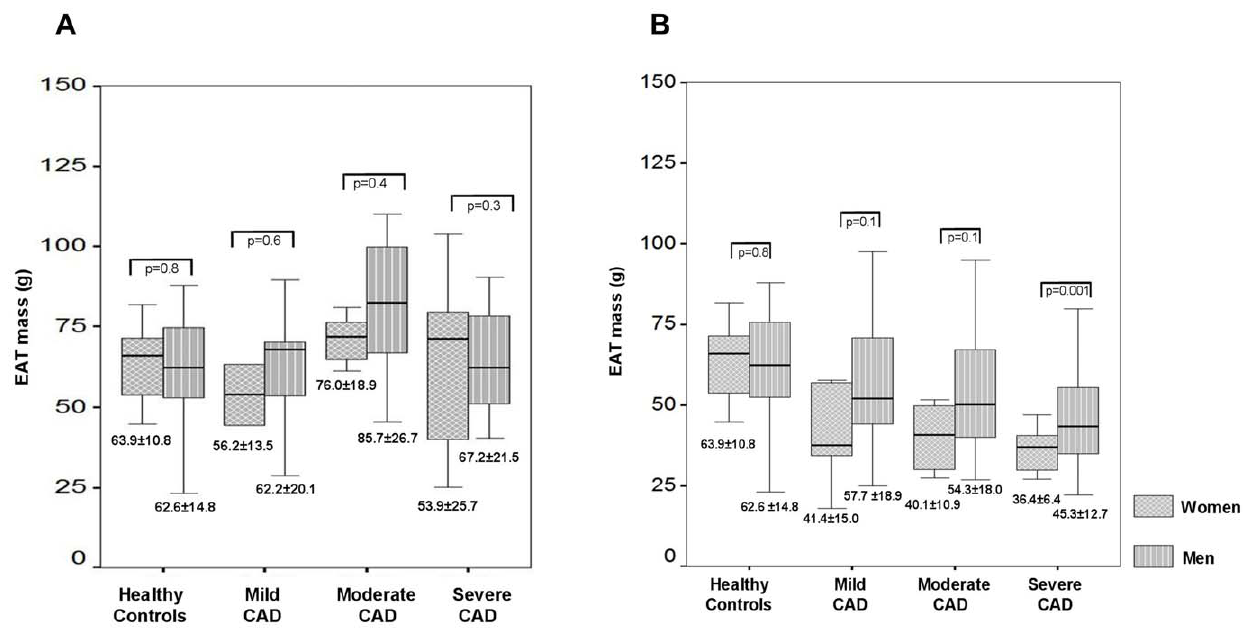
Figure 4. Relationship between EAT and atherosclerosis severity with regard to gender. The box plots demonstrate the relationship between EAT mass and atherosclerosis severity with regard to gender in patients with preserved LVF (LVF $ 50%, Panel A) and reduced LVF (LVF , 50%, Panel B). EAT mass in men is indicated by striped box plots, whereas EAT mass in women is shown by squared box plots. The p-values for the differences of the EAT mass between men and women are also indicated. EAT mass is given as mean 6 standard deviation below the box plots, the line in the box plots indicates the median value of the data. In patients with preserved LVF $ 50% (Panel A) and mild CAD (GSS # 10), EAT mass was comparable to healthy controls (white boxplot). With increasing atherosclerosis severity, EAT mass rose significantly in patients with moderate CAD (GSS . 10 2, 40). However, in patients with severe atherosclerosis (GGS . 40), EAT mass already started to decline. This EAT course was comparable in men and women. In patients with reduced LVF , 50% (Panel B), EAT mass was significantly reduced compared to healthy controls (white boxplot) and showed a stepwise decline with increasing atherosclerosis severity in men and women. Abbreviations: CAD: coronary artery disease, EAT: epicardial adipose tissue, LVF: left ventricular function, GSS: Gensini